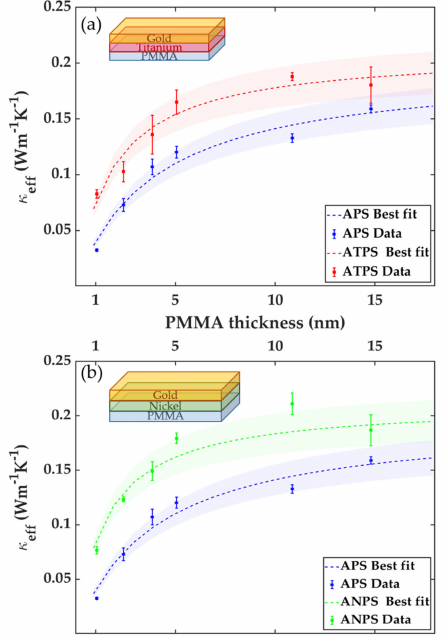
Figure 5. ( a ) E ff ective thermal conductivity of APS and ATPS samples. ( b ) E ff ective thermal conductivity of APS and ANPS samples. Dashed lines are the best fit of the experimental data to the series thermal resistance model using κ PMMA and G as free parameters. Error bars are calculated from the standard deviation error in the thermal measurements. The shaded area around the fit curve corresponds to the 10% total experimental